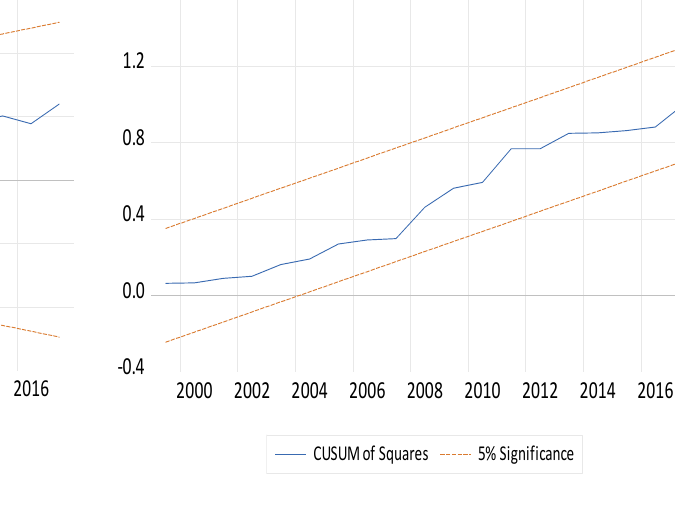
Figure 3. Stability test. Table 5. ARDL approach to cointegration.